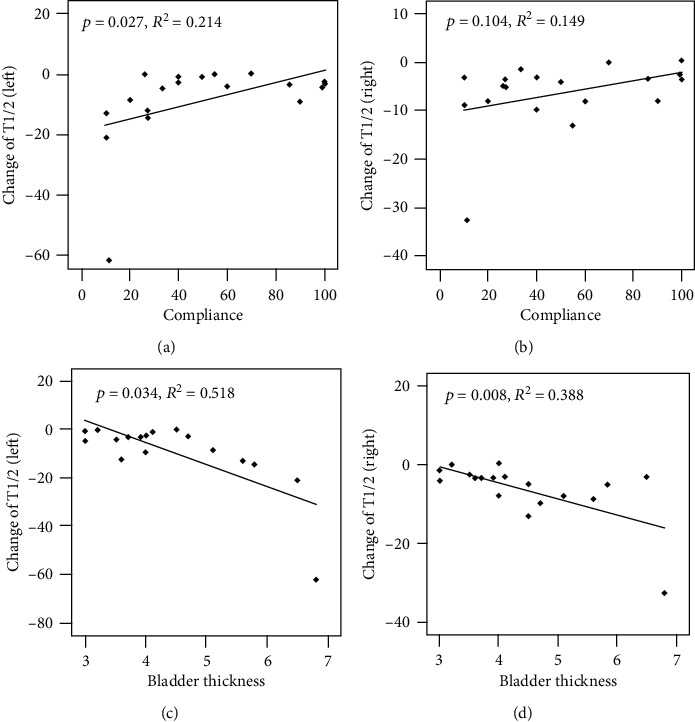
Changes in the T1/2 of the diuretic 99mTc-MAG3 scan according to preoperative bladder compliance and bladder thickness. (a, b) The preoperative bladder compliance was lower, and the change in the T1/2 of the diuretic 99mTc-MAG3 scan was greater. (c, d) The preoperative bladder was thicker, and the change in the diuretic 99mTc-MAG3 scan was greater.